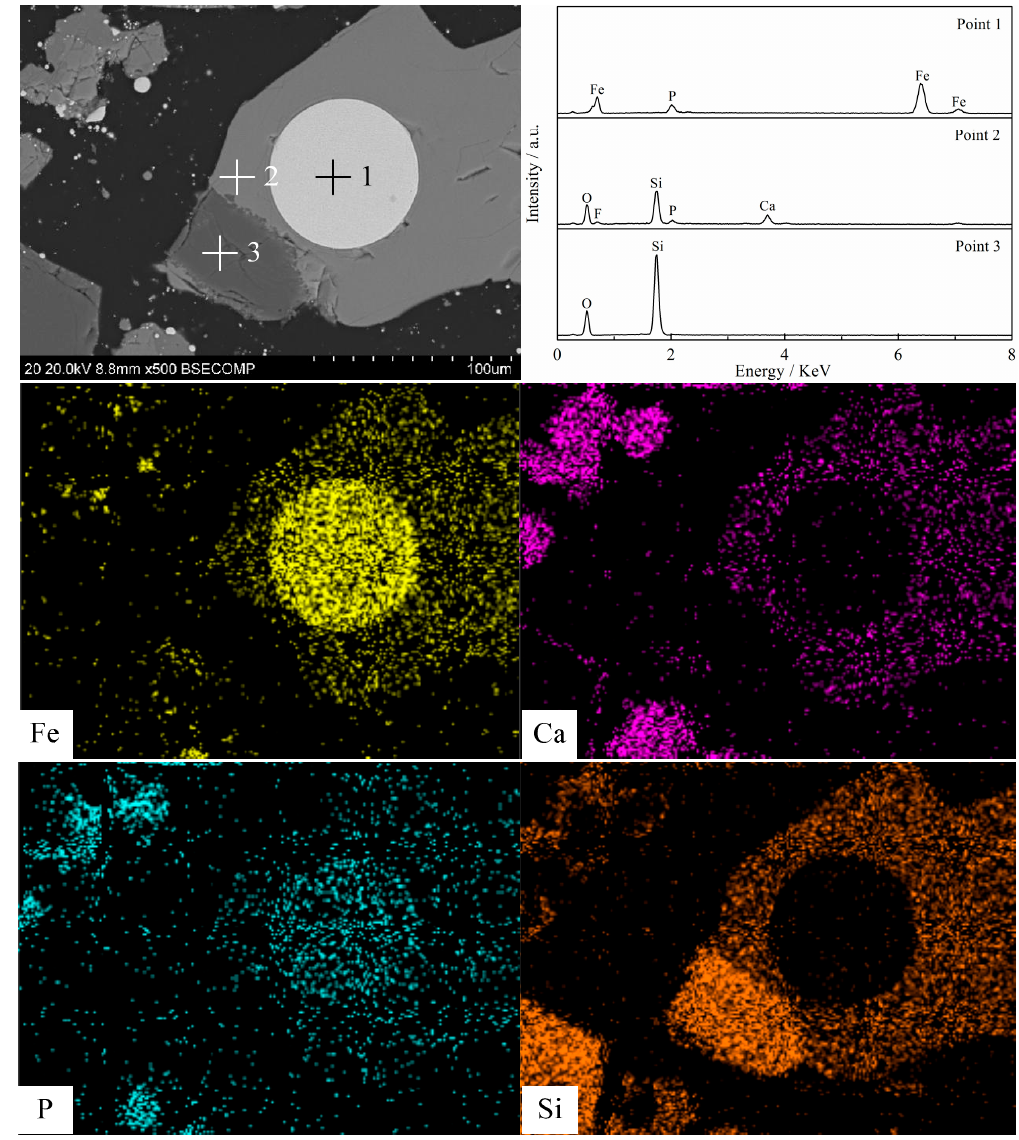
Figure 14. SEM image and EDS spectra and line-by-line scanning analysis of the reduction product in